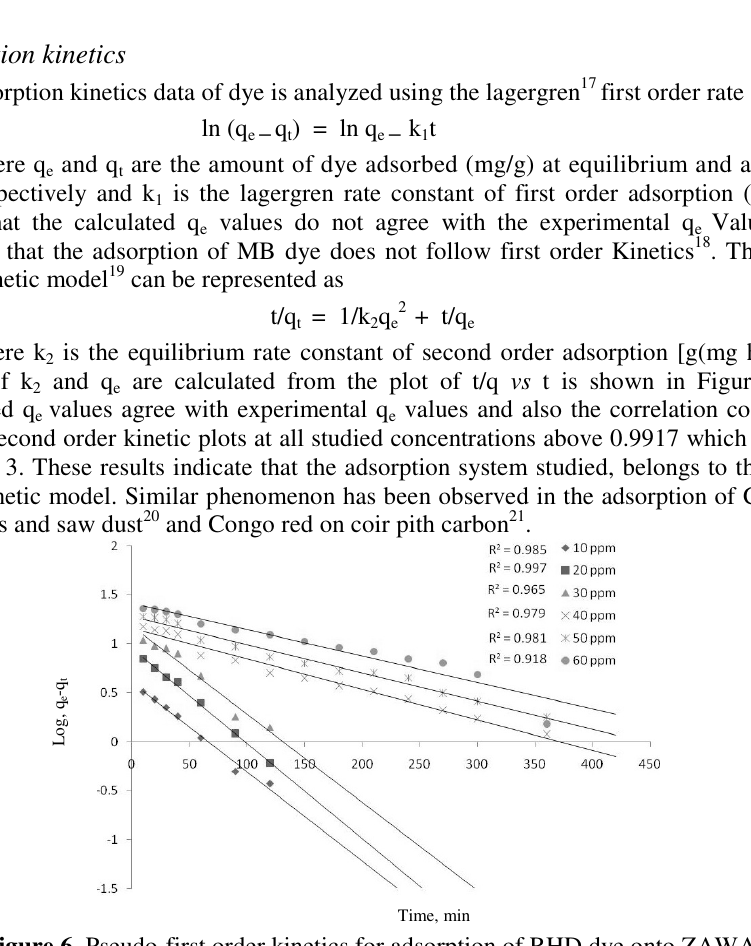
Figure 6. Pseudo-first order kinetics for adsorption of RHD dye onto ZAWAC